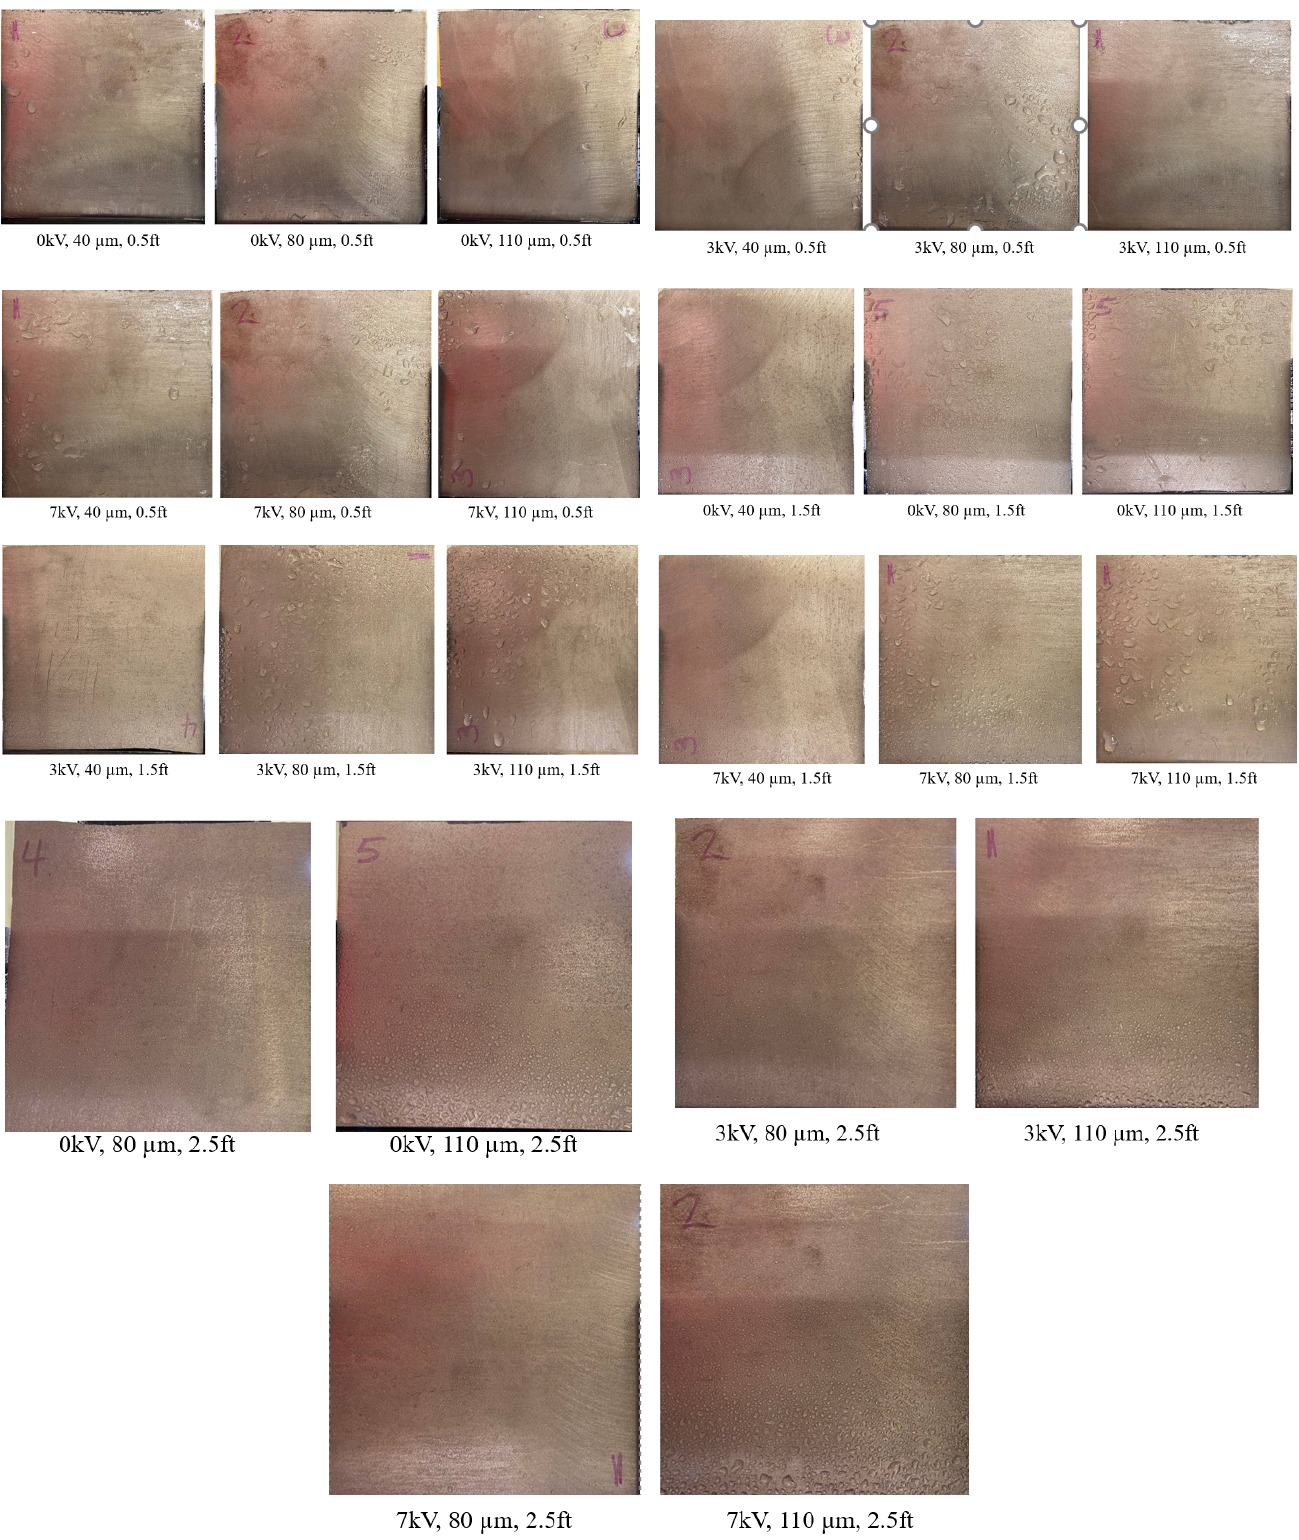
Figure A15. Stainless steel: qualitative images of electrostatic deposition at various system